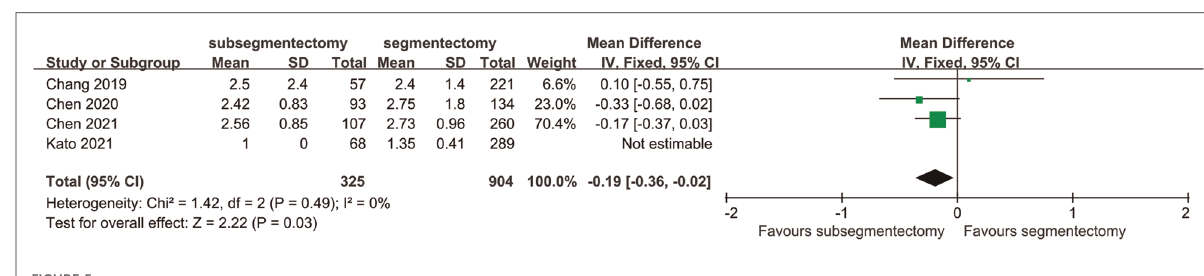
FIGURE 5 Forest plot: the duration of drainage of subsegmentectomy vs. segmentectomy.